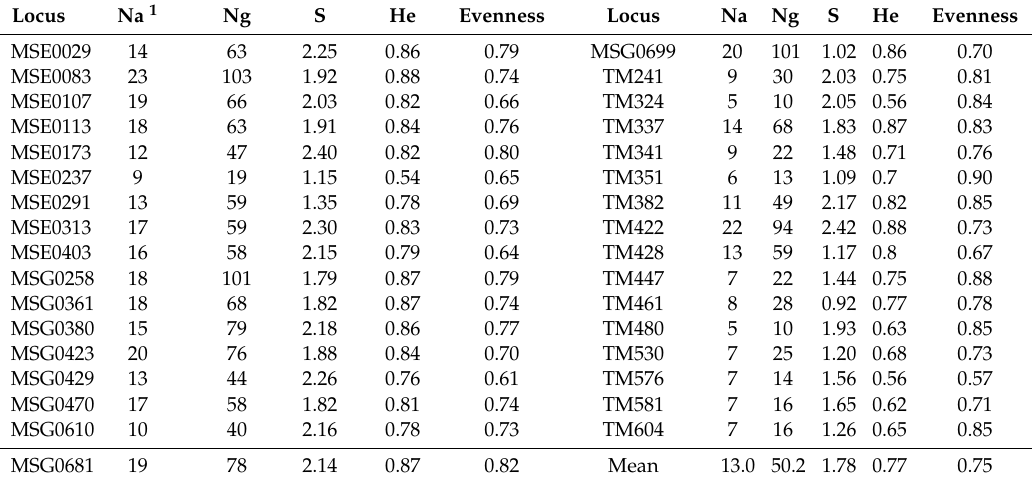
Table 3. Genetic diversity parameters of the 33 SSR markers in the 462 tea accessions.